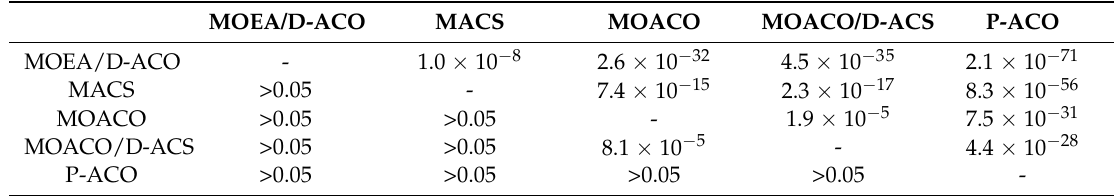
Table 3. Kruskal–Wallis test on kroAB100 based on H-indicator.